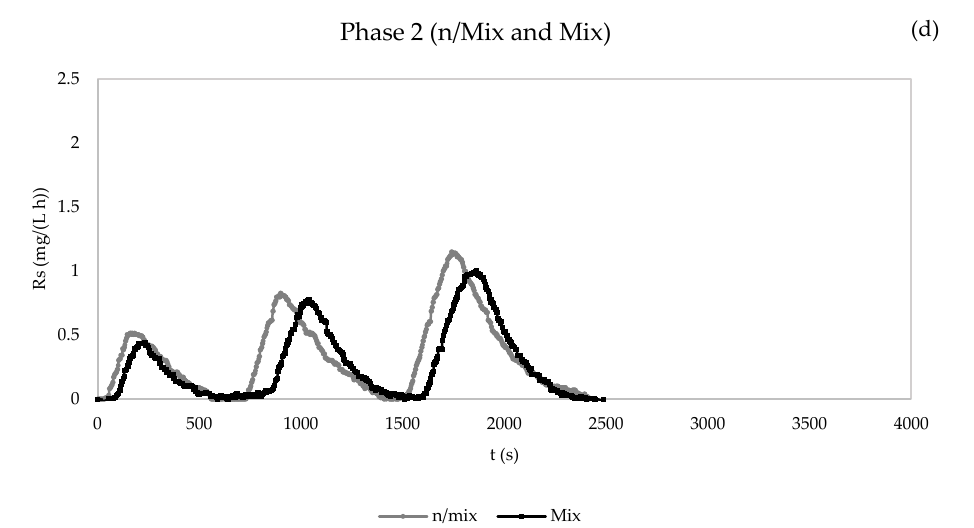
Figure 5. Evolution of dynamic oxygen uptake rate (R s ) in the respirometric experiments in the absence and presence of pollutants for the determination of the kinetic parameters. ( a ) Phase 2: control without BPA and with BPA. ( b ) Phase 2: control without carbamazepine and with carbamazepine. ( c ) Phase 2: control without ciprofloxacin and with ciprofloxacin. ( d ) Phase 2: control without pharmaceuticals and with mixture of pharmaceuticals. n/BPA: absence of bisphenol A. BPA: presence of bisphenol A. n/CBZ: absence of carbamazepine. CBZ: presence of carbamazepine. n/CPF: absence of ciprofloxacin. CPF: presence of ciprofloxacin. n/Mix: absence of mix of pharmaceuticals. Mix: presence of mix of pharmaceuticals.